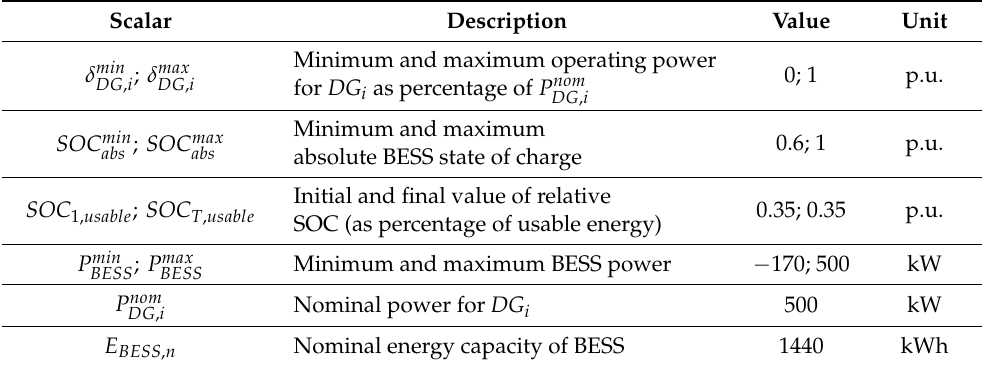
Table 3. List of scalars in the LP model and the set of values used in the case study micro-grid.